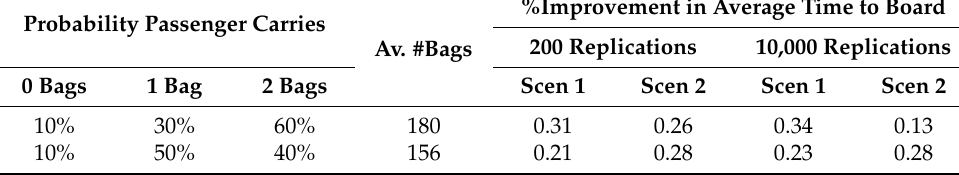
Table 4. %Improvement for the proposed method with respect to the two scenarios, varying the number of